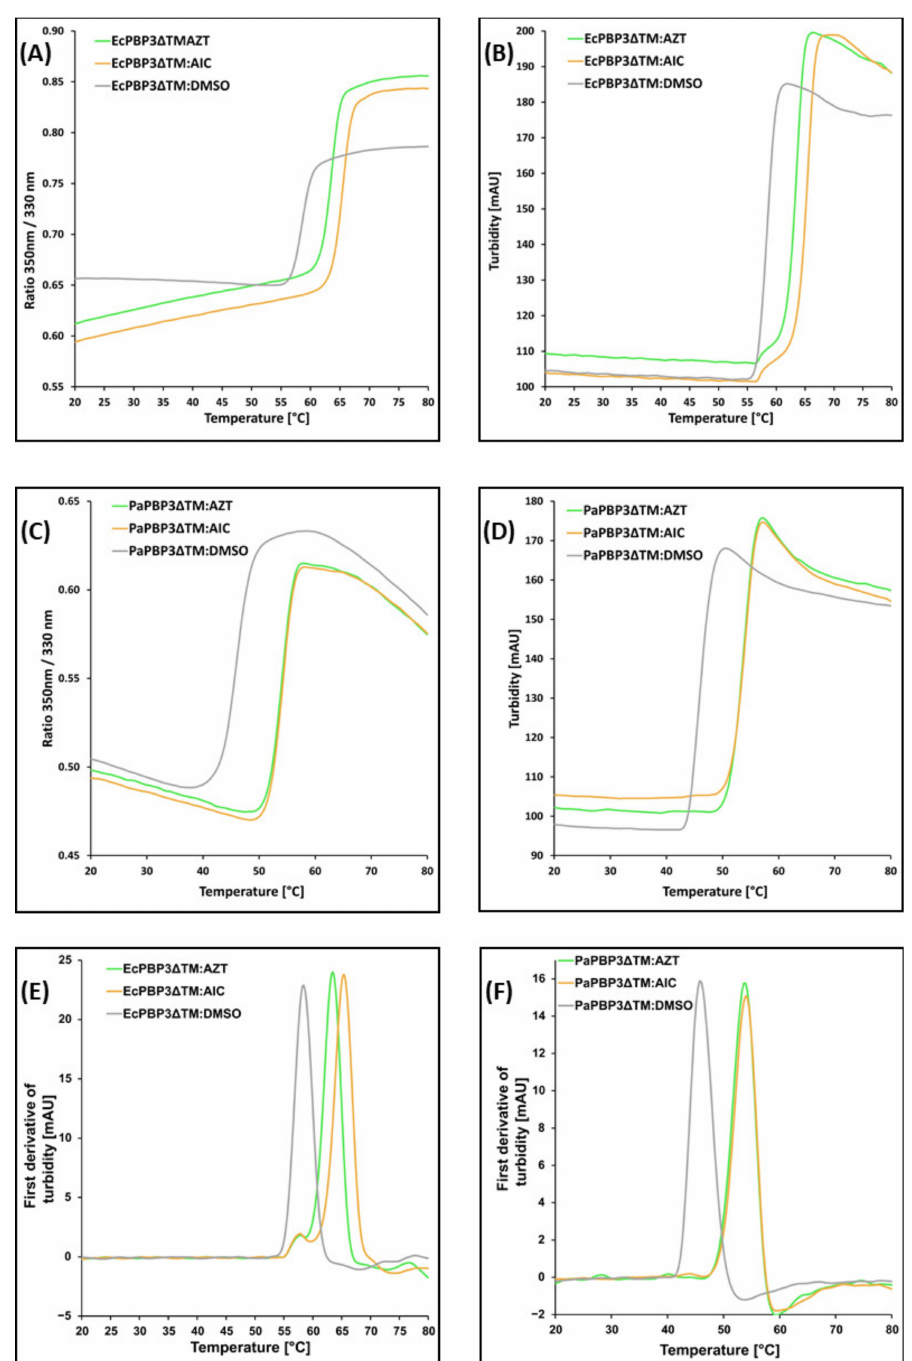
Figure A1. Raw data of the thermal shift experiments. In the upper row, the ratio of 350 nm/330 nm fluorescence ( A ), the turbidity ( B ) are plotted against temperature. T m derived from turbidity mea- surements were determined to be 58.4 ◦ C for apo- Ec PBP3 ∆ TM, and 63.4 and 65.3 ◦ C for Ec PBP3 ∆ TM in complex with aztreonam and AIC499, respectively. In the middle row, the analogous data are shown for Pa PBP3 ∆ TM ( C , D ). T m were calculated to be 45.9, 53.8 and 54.0 ◦ C for the DMSO con- trol, Pa PBP3 ∆ TM in complex with aztreonam and with AIC499, respectively. In the bottom row, the first derivatives of the turbidity are plotted for Ec PBP3 ∆ TM and Pa PBP3 ∆ TM, respectively ( E , F ). The reference experiments with addition of DMSO only are displayed in gray, whereas the graphs for complexes with aztreonam and AIC499 are colored green and gold,